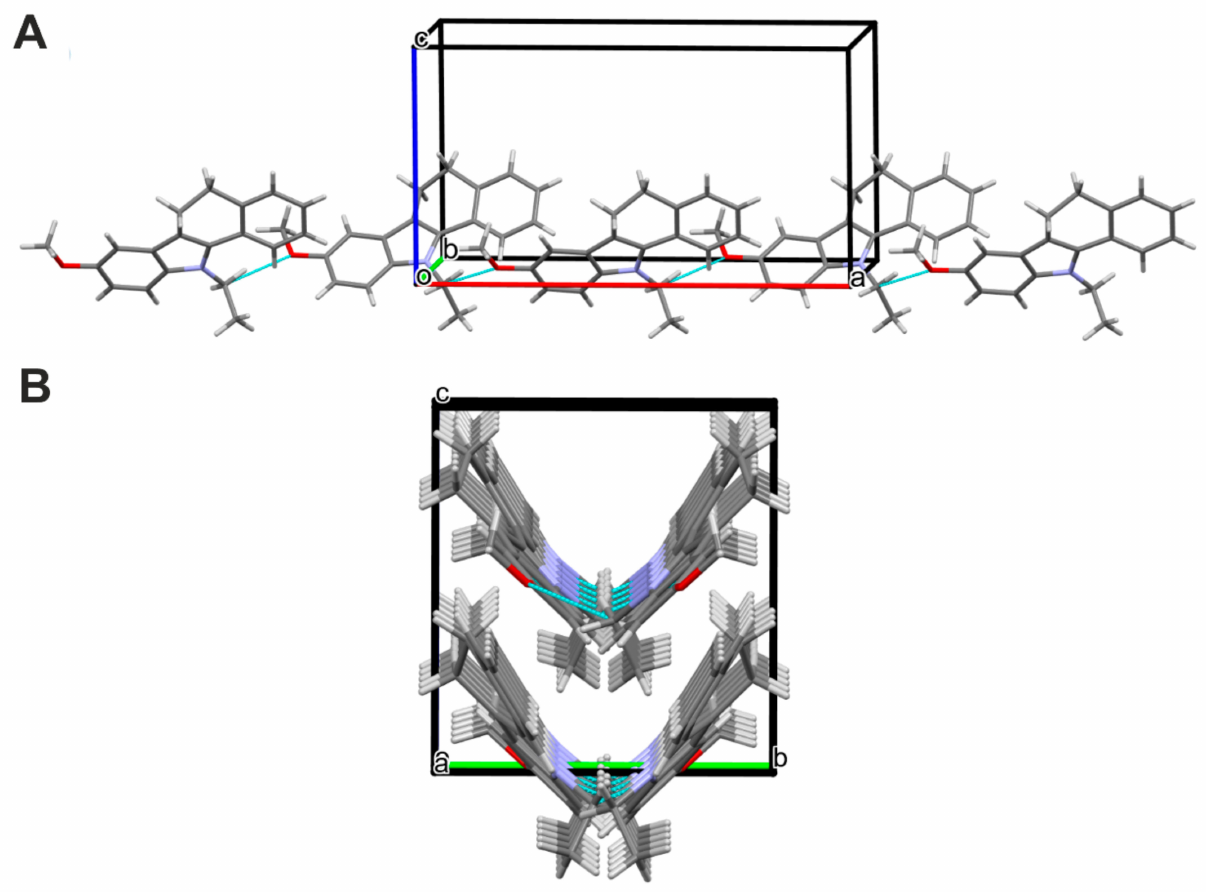
Figure 6. ( A )—Part of the crystal structure of 4 , showing a molecular chain, which propagates parallel to the a -axis. ( B )—Part of the crystal structure of 4 , showing the V-shaped chains’